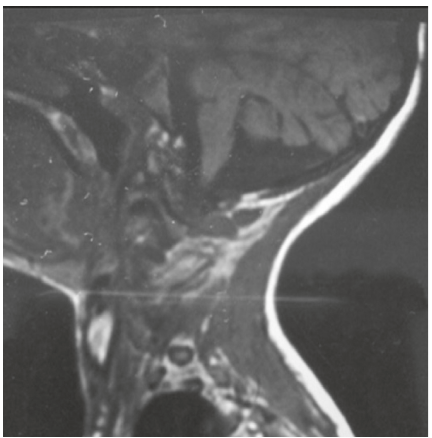
Figure 3: Postoperative X-ray showing correction of scoliosis with implants in